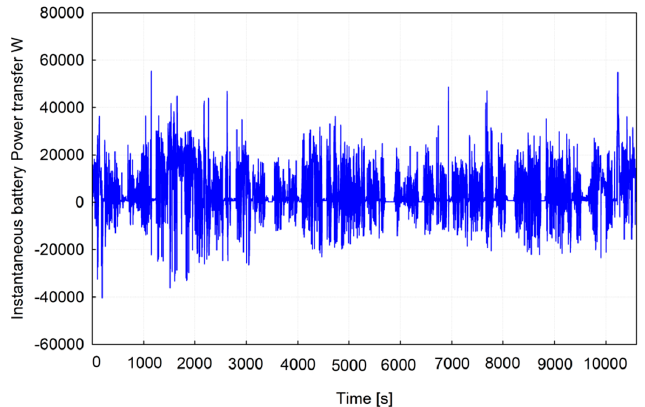
Figure 9. Plot of V × I (W) rebased against time.